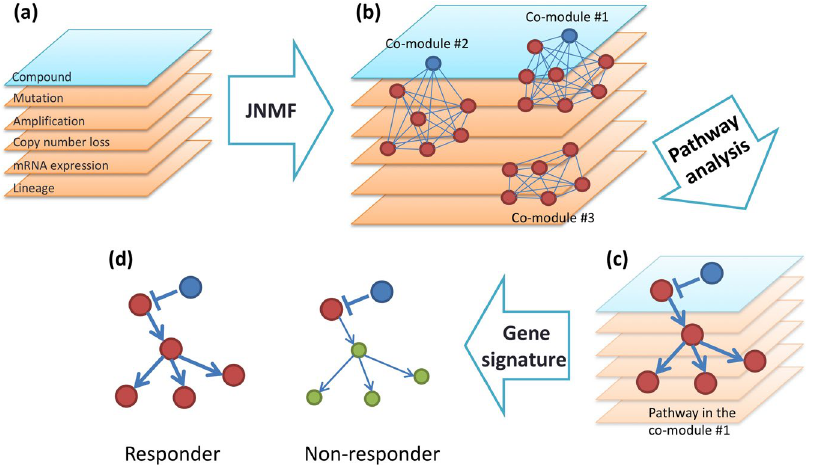
Figure 1. Biomarker discovery scheme. ( a ) Input matrices are multi-dimensional pharmacological, genomic, transcriptomic, and tumour-type data aligned by cell lines. ( b ) The joint non-negative matrix factorization (JNMF) method detects multi-dimensional co-modules. Each module shows the co-occurrence between genetic (red) and pharmacological (blue) features. ( c ) Pathway analysis provides causal relationship based on biological knowledge in co-module features. ( d ) Gene signature analysis clarifies the relationship between pathway activation and sensitivity to